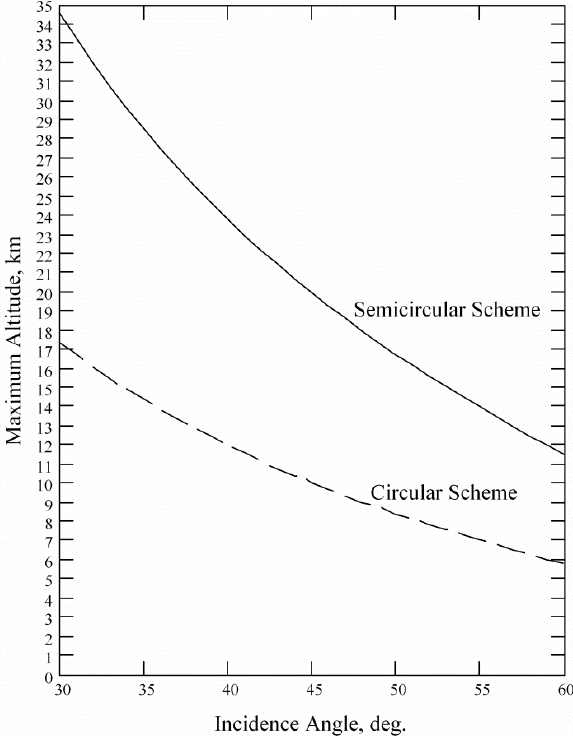
Figure 2. The maximum altitude of the wind retrieval method’s applicability depending on the azimuth NRCS sampling scheme and the incidence angle.